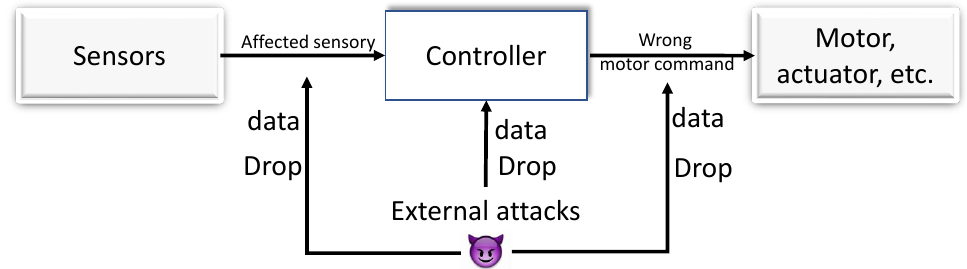
Figure 3. A pictorial representation of typical